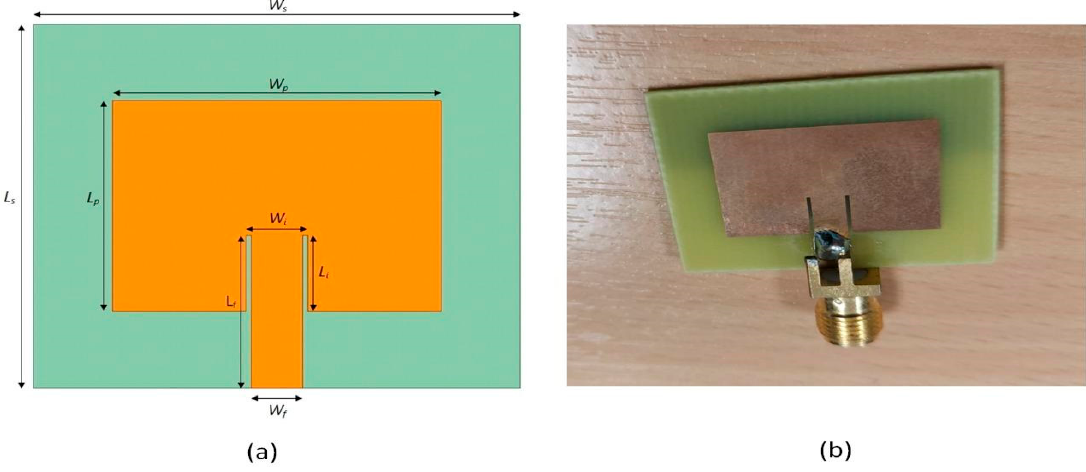
Figure 2. ( a ) Front view of the proposed MPA. ( b ) Fabricated Prototype.